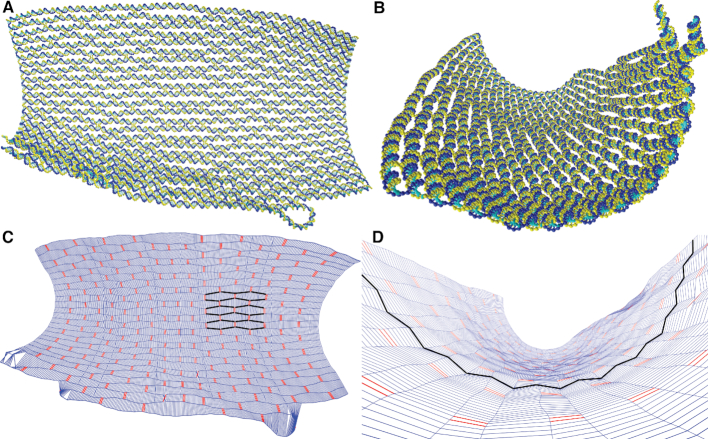
(A, B) Different representations and viewpoints of the average structure of the 2D origami. (C) and (D) provide a ‘chickenwire’ representation of the tile. In (C) the tile is shown from the front so that the weave pattern can be clearly seen (as highlighted by helix axes in black); and (D) at an angle to show the corrugation pattern on the tile’s surface (as highlighted by the inter-helix vectors in black). In (C) lines running horizontally along the origami show the axes of the double helices that make up the origami; pairs of red vertical lines represent double crossovers, while blue vertical lines represent the inter-helix vectors used for the quantitative analysis of the weave and corrugation. Deviations from the typical structure, such as that seen in the bottom left corner of the origami, are caused by staple melting or branch migration.